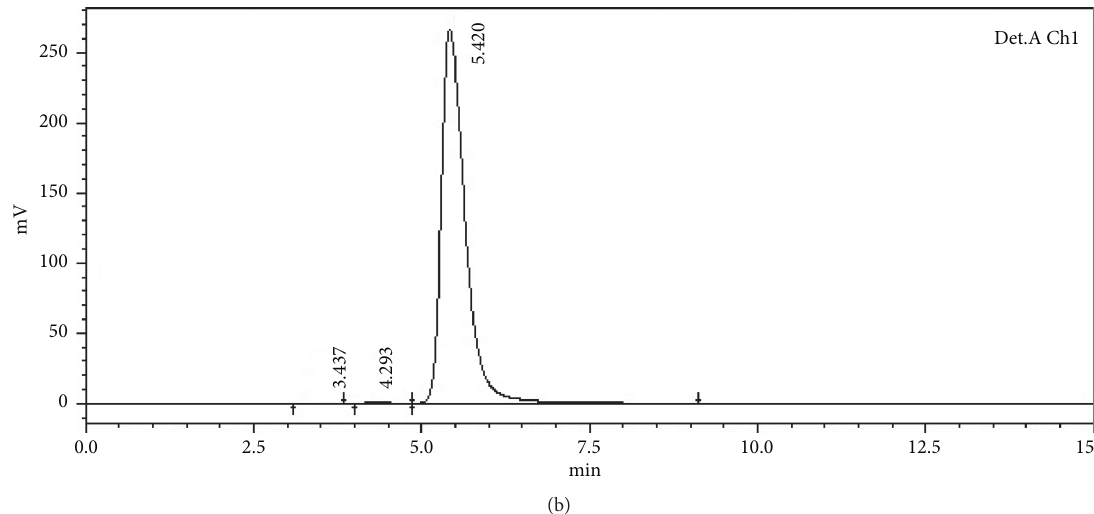
Figure 4: Chromatogram showing the peaks of lamivudine and tenofovir in a sample B 3.27 and 7.55 minutes, and 5.42 minutes,